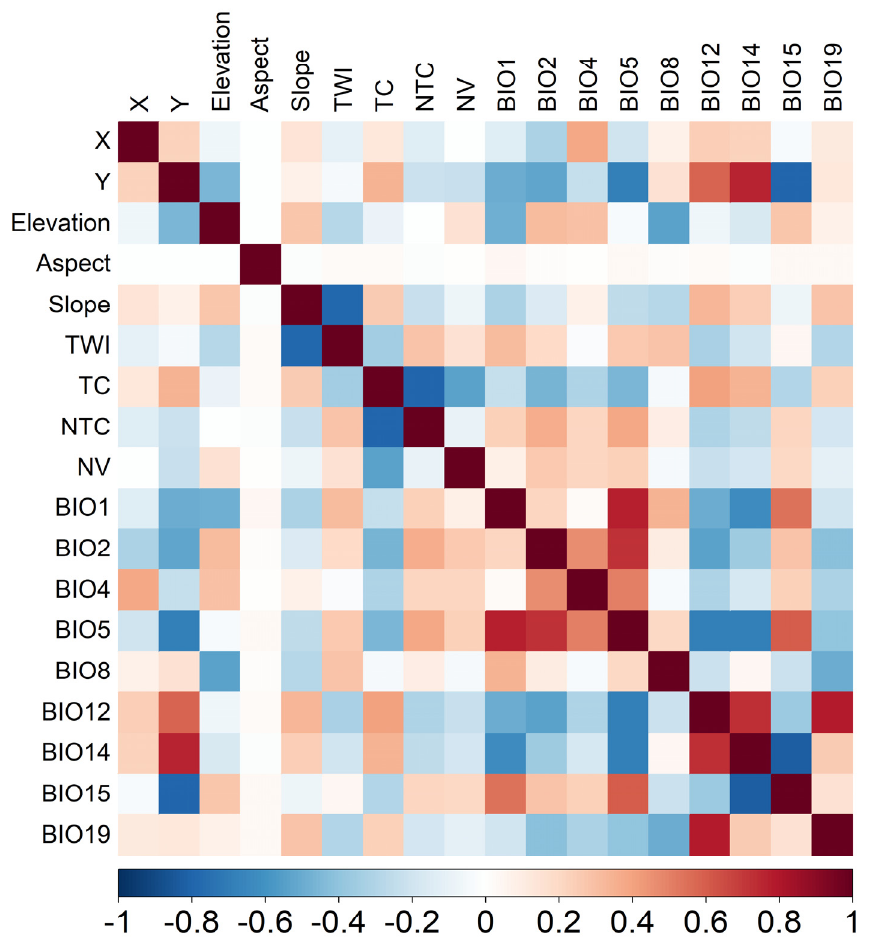
Figure 3. Correlation matrix of the used environmental variables of the reference period. See Table 1 for the description of the variables.